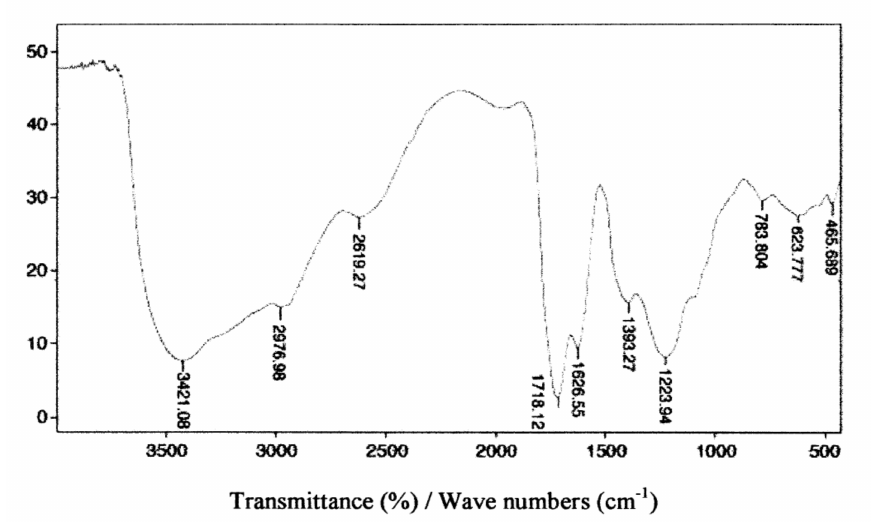
Figure 12. Spectrum of fulvic acids extracted from colloids present in water following the coagulation process using the highly alkaline PAXXL1911